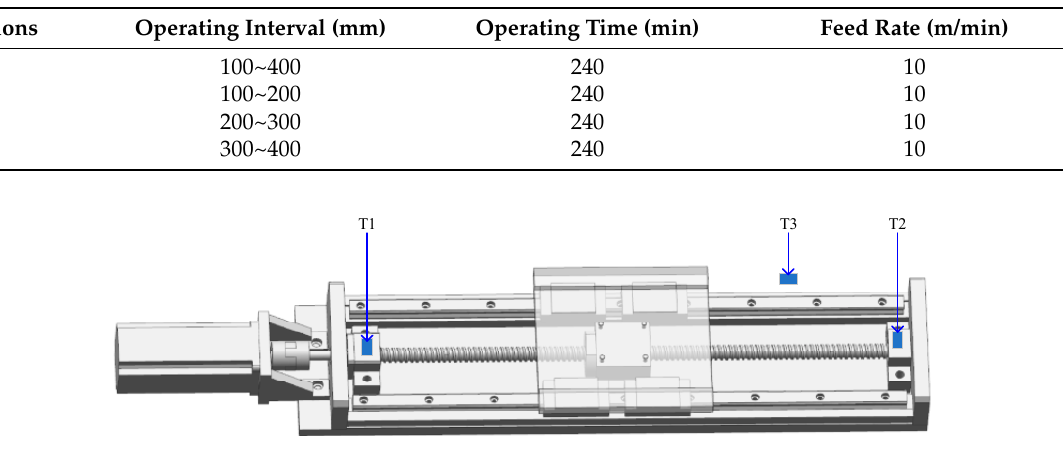
Figure 2. The layout of the temperature sensors.